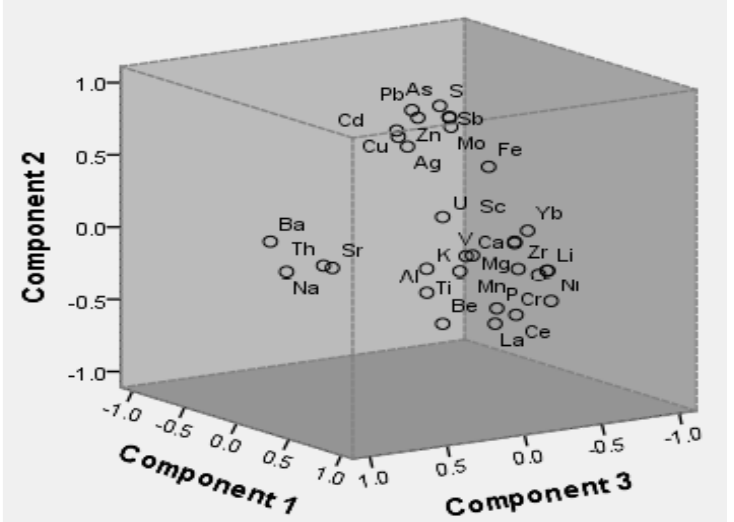
Figure 3. Result of principal component analysis (PCA) in soil samples that shows the difference between natural origin and anthropogenic origin of different elements.